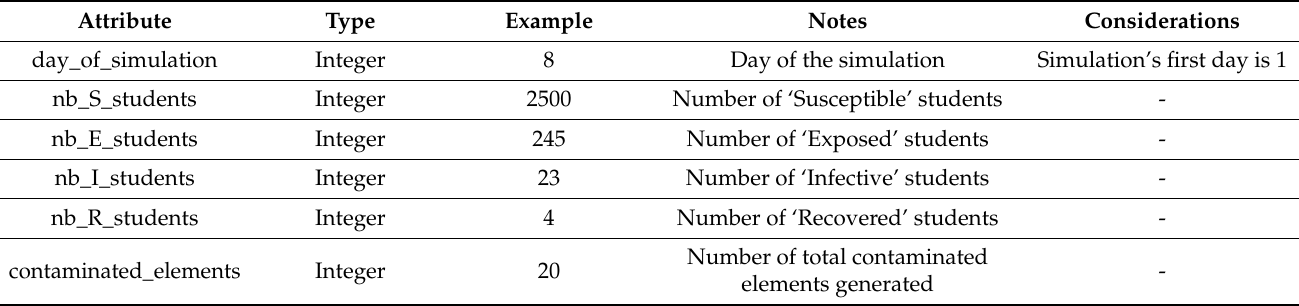
(Table A8) and Transmission_list.csv (Table A9). Table A7. ABM_SEIR_values_per_day.csv attribute table.